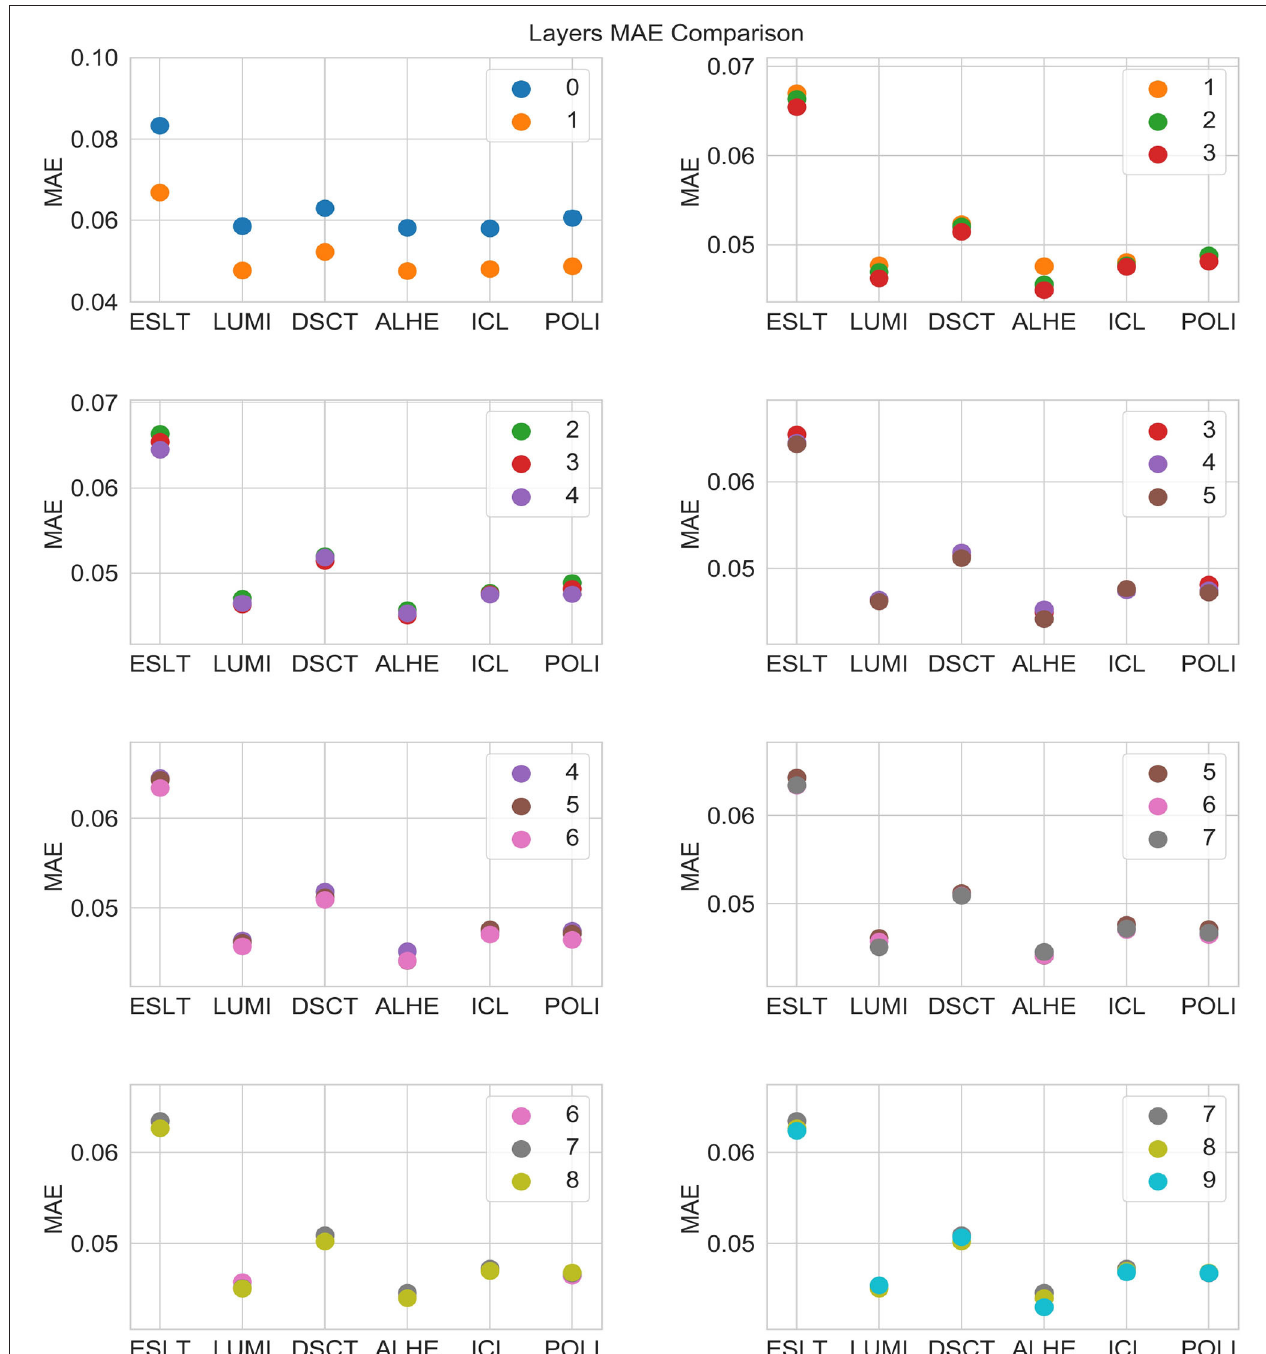
FIGURE 5 | MAE by number of layers and